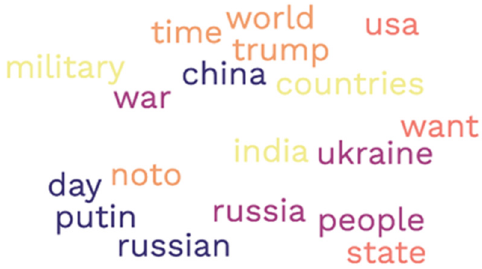
Figure 10. Word Cloud for Cluster 0 of Russia Ukraine tweets.